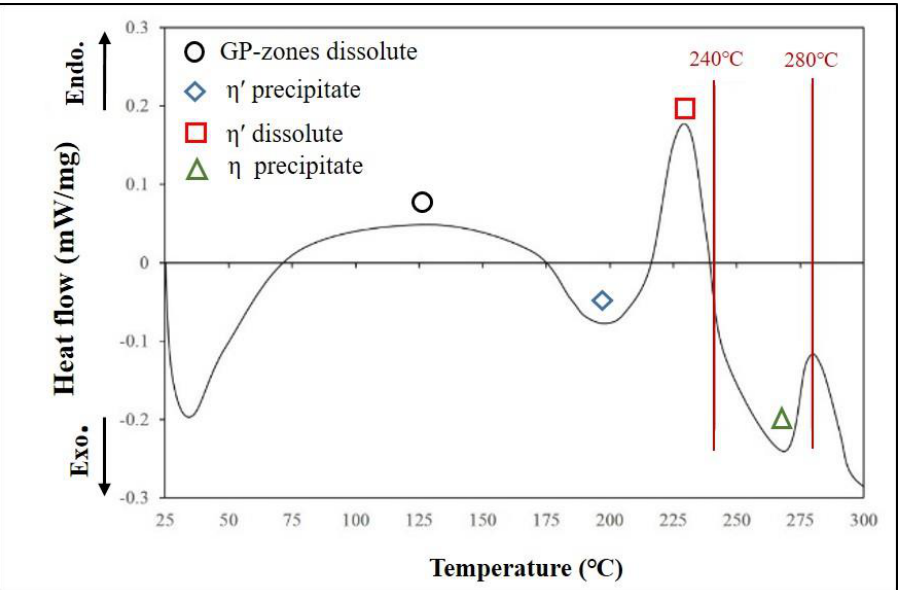
Figure 1. Differential scanning calorimetry (DSC) analysis of the 7075 aluminum alloy extruded rod.